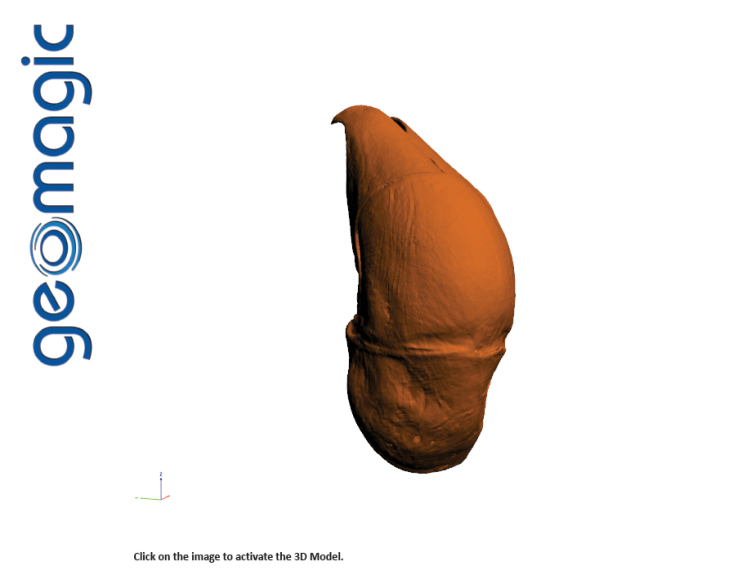
3D model for aedeagus of Callistethus
hamus Lu & Zorn, sp. nov. in pdf format.